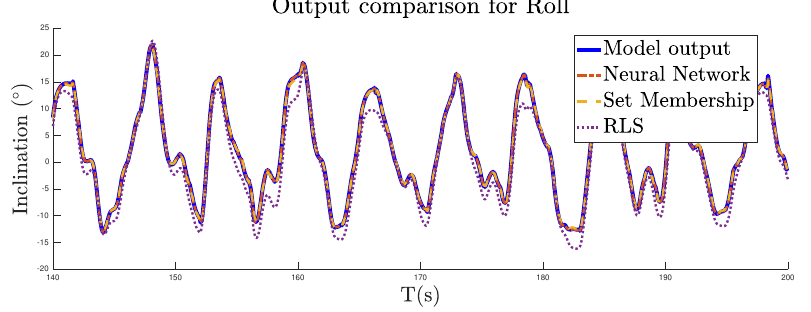
Figure 10. Validation of the roll output. Table 3. Fitness of models on the validation data.